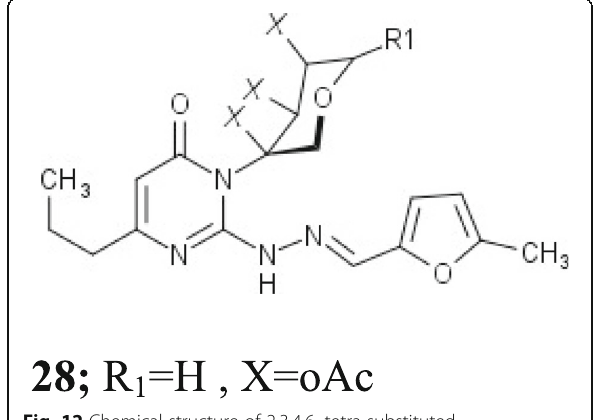
Fig. 12 Chemical structure of 2,3,4,6 – tetra substituted